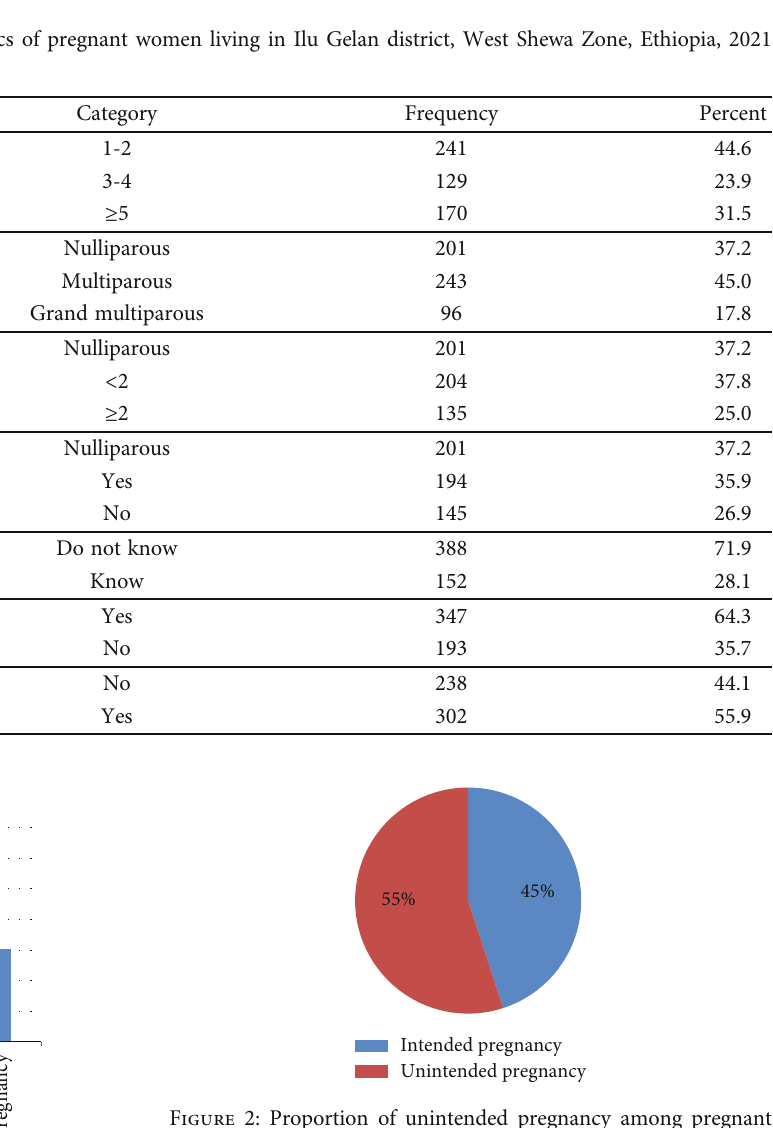
Figure 2: Proportion of unintended pregnancy among pregnant women living in Ilu Gelan district, West Shewa Zone, Ethiopia, 2021 ( n = 540